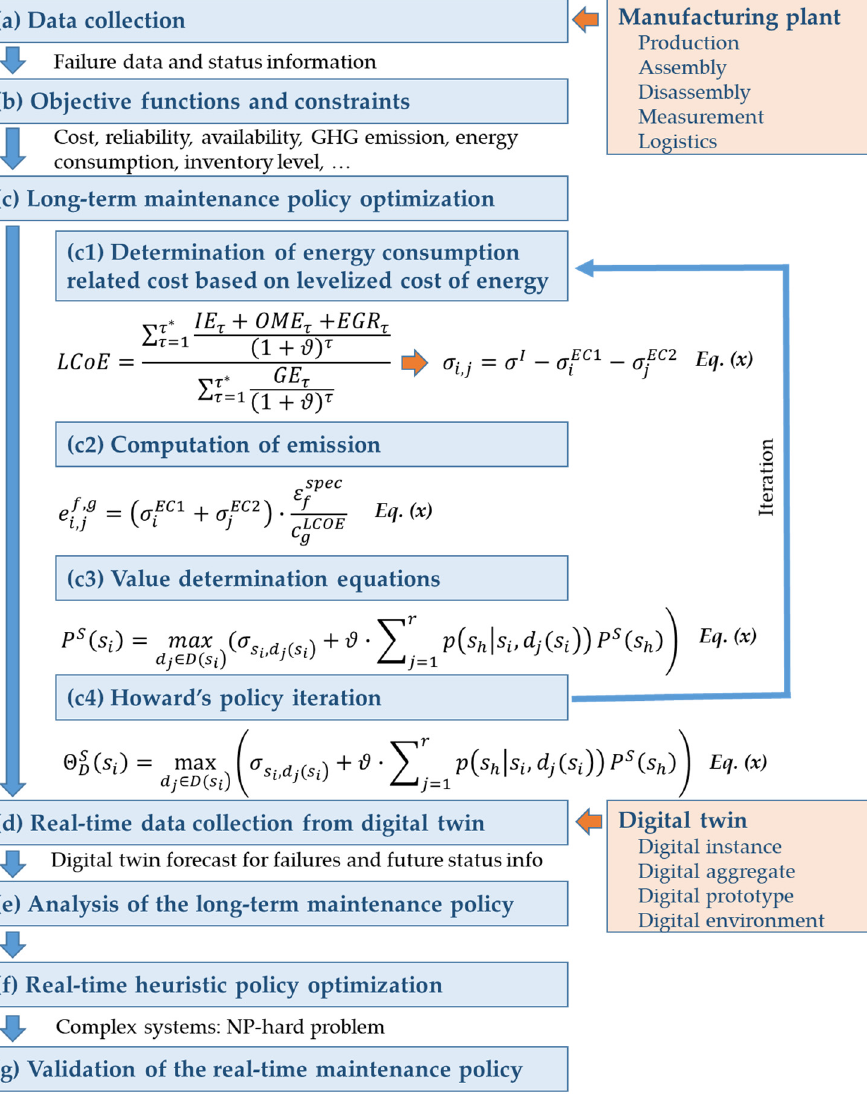
Figure A3. Multi-level maintenance policy optimization based on Howard’s policy iteration method and heuristic real-time policy optimization.